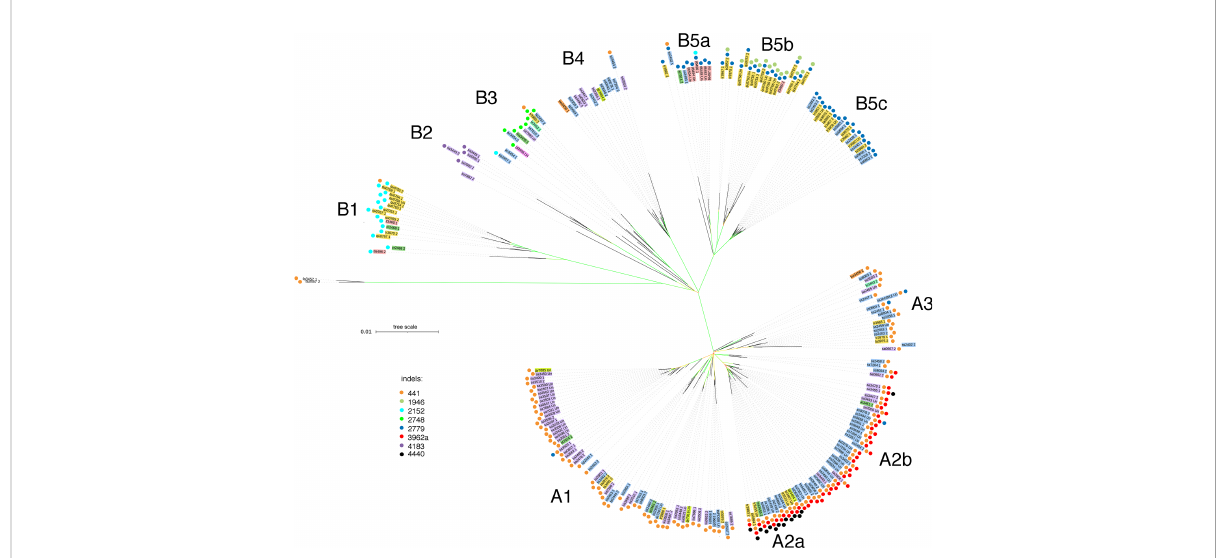
FIGURE 4 Phylogenetic tree of 225 CaTA alleles of 9 Camellia species of section Thea . CaTA from C. fangchengensis was used as outgroup. Accessions are marked by abbreviations corresponding to their full names given in Supplementary Table 1 and the last 4 digits of the SRX number. Color codes indicate the different species (according to Min and Bartholomew, 2007). C. sinensis var. assamica belongs to C. sinensis , but was given a special color code (purple). C. sinensis : blue (these comprise C. sinensis var. sinensis , C. pubilimba , C. angustifolia ). C. tachangensis ( C. tachangensis var. tachangensis , C. tachangensis var. remotiserrata , C. quinquelocularis , C. tetracocca ): dark yellow, C. crassicolumna ( C. crassicolumna , C. atrothea , C. makuanica ): green, C. gymnogyna : yellow, C. taliensis : pink, C. leptophylla : dark green, C. kwangsiensis : orange, C. ptilophylla : red, C. fangchengensis : no color. On the outside, the indels are marked with colored dots. Orange: deletion at G240-CaTA coordinate 441. Dark green: insertion at 1946. Light blue: insertion at 2152. Light green: insertion at 2748. Dark blue: deletion at 2779. Red: deletion at 3962a. Purple: deletion at 4183. Black: deletion at 4440. The various groups cluster into 2 main groups, A and B. A can be further subdivided into A1-A3, A2 into A2a and 2b. Group B is subdivided into B1-B5, B5 into B5a-c. In general, indel distribution corresponds to overall tree topology, but exceptions occur. Group B3 contains CaTAs of 5 different species, all have the 2748 plant sequence insert. B ootstrap values are color-coded : green 85-100%, yellow around 50-85%, red: less than